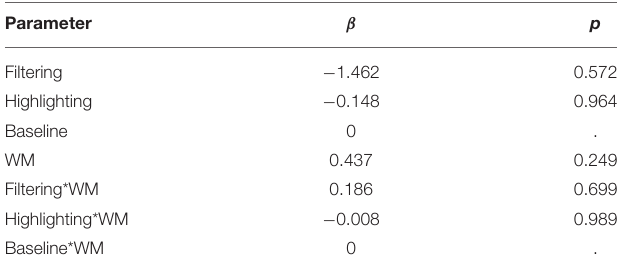
TABLE 8 | Experiment 4, effect sizes for main effects of condition, visual working memory, and the interaction between